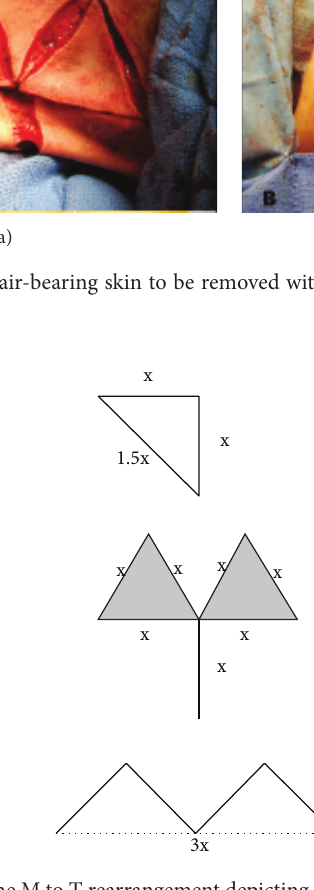
Figure 6: A diagrammatic view of the M to T rearrangement depicting the effective lengthening needed to treat the webbing.